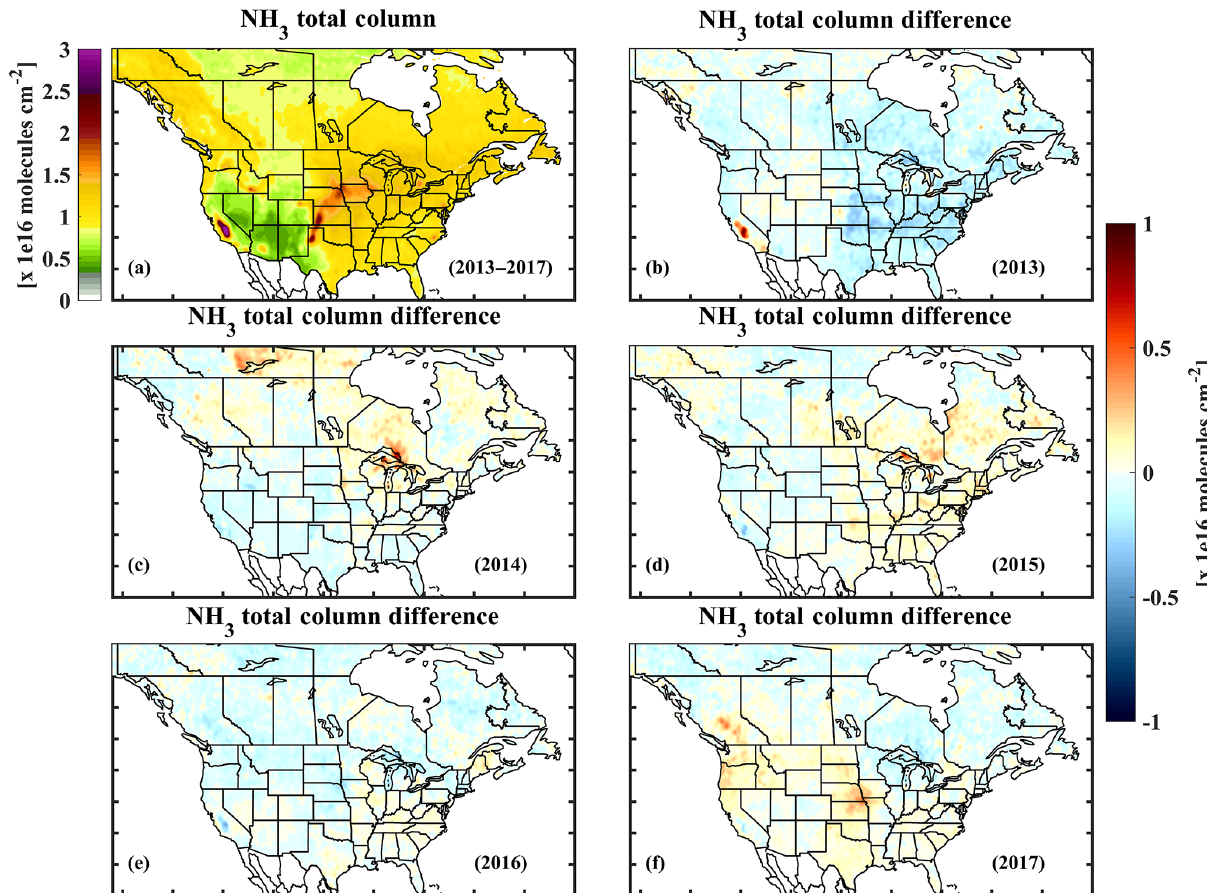
Figure C3. Similar to Fig. 11 but for total column ammonia